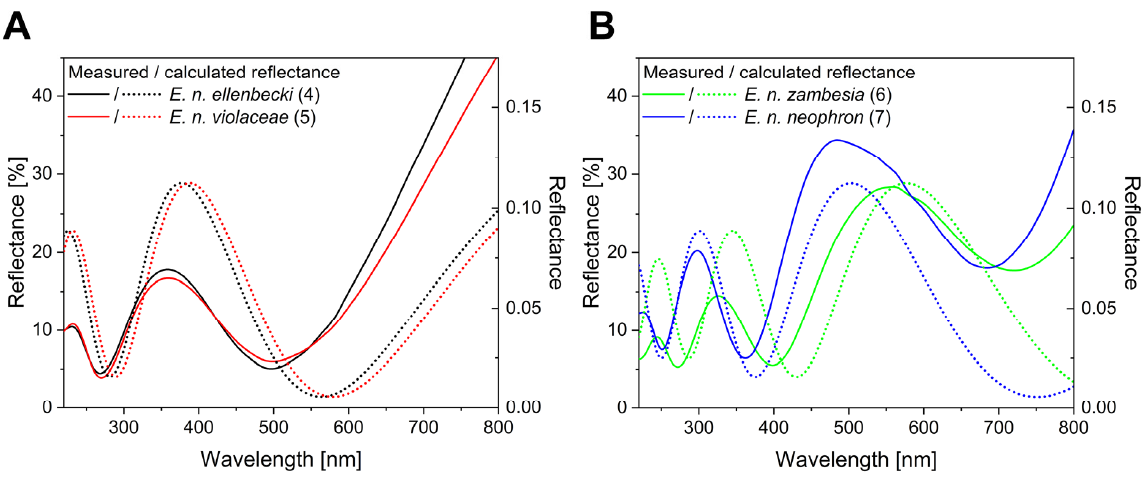
Figure 7. Measured and simulated reflectance spectra of Euphaedra neophron (with sample numbers): ( A ) E. n. ellenbecki (4) and E. n. violaceae (5); ( B ) E. n. zambesia (6) and E. n. neophron based on reflectance measurements and SEM images, respectively.